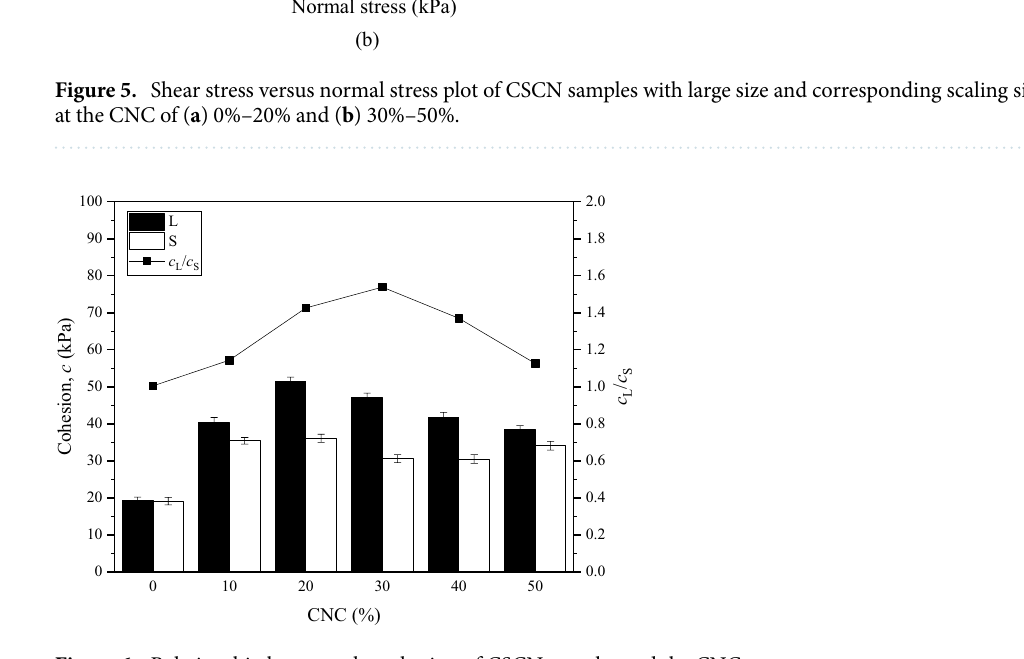
Figure 6. Relationship between the cohesion of CSCN samples and the